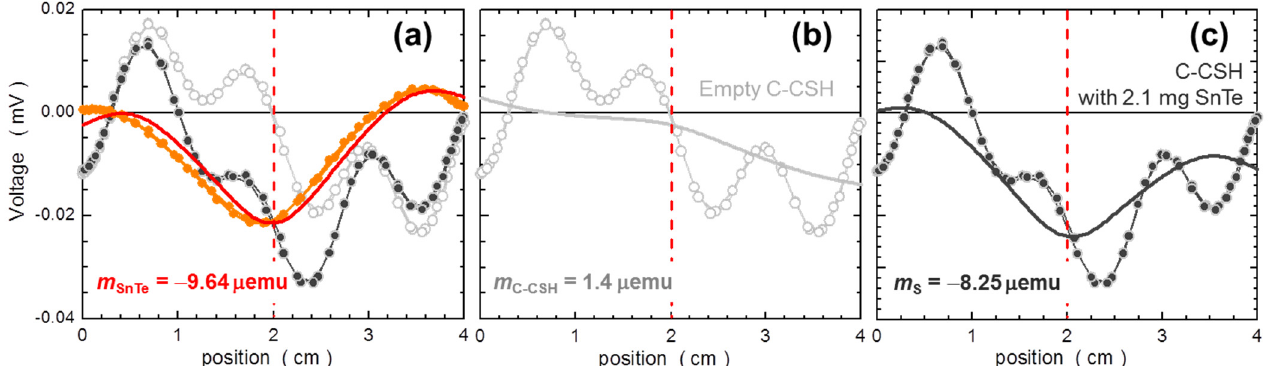
Figure 14. Exemplary scans (the long averaged scaled response voltages) representing the first experimental point of the temperature dependence of magnetic susceptibility of a 2.1 mg SnTe crystallite depicted by brown symbols in Figure 13. Light grey open symbols in ( a , b ) mark the scan of the empty capsule compensational sample holder (C-CSH). Dark grey symbols mark the scan obtained with the 2.1 mg SnTe piece installed in the central capsule of the C-CSH. The orange symbols in ( a ) mark the difference between scans presented in ( c , b ). The solid lines in matching colors in all three panels represent least mean square fit of the SQUID response function (defined in Appendix B) to the experimental points. The corresponding magnetic moments m are given in the labels.